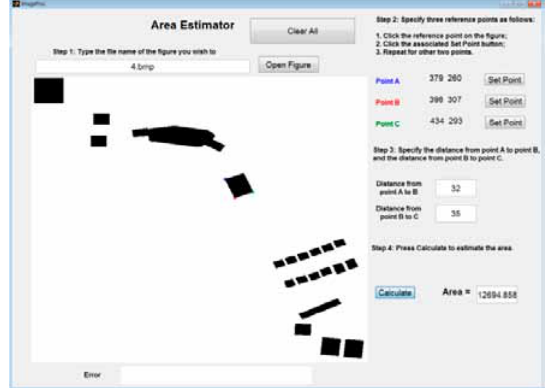
Fig. 5. Screen shot of image processing tool created in